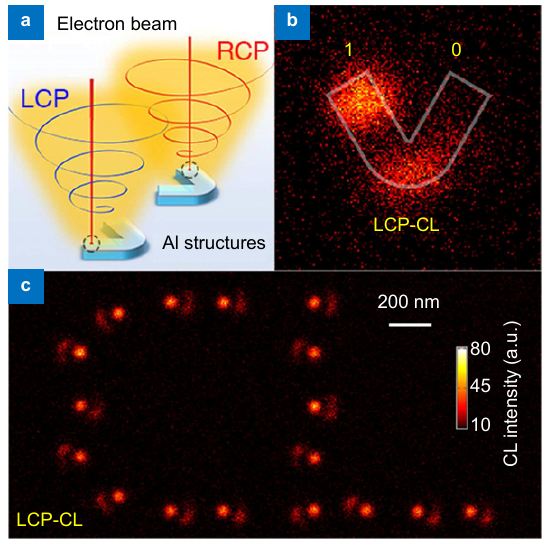
Fig. 9 | ( a ) Schematic of circular polarization resolved Al nanoantenna with electron beam excitation. ( b ) LCP CL image of a single nanostructure with a bandpass of 657 nm. ( c ) LCP CL image for the helicity-dependent 2D display of capital letters “CL”. Figure reproduced from ref. 74 , ACS